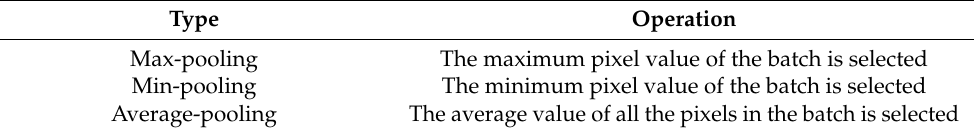
Table 6. Three types of pooling